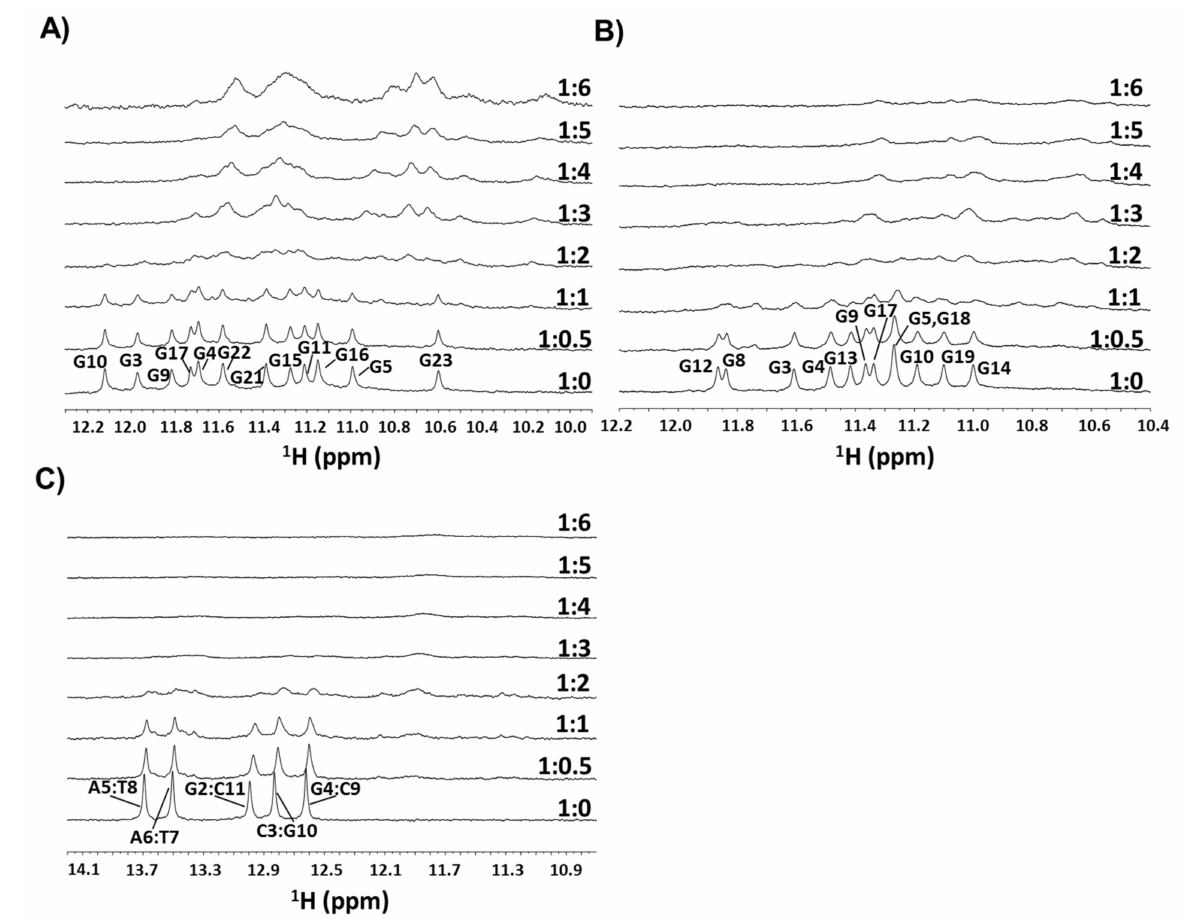
Figure 2. Imino proton regions of the 1 H NMR spectra of ( A ) m-tel24 G-quadruplex, ( B ) M2 G-quadruplex and ( C ) ds12 duplex upon titration with c ex -NDI (from 0.5 to 6 equivalents). DNA/ c ex -NDI ratios are shown on the right of the corresponding spectrum. Resonances for free G-quadruplexes and duplex were assigned according to refs.